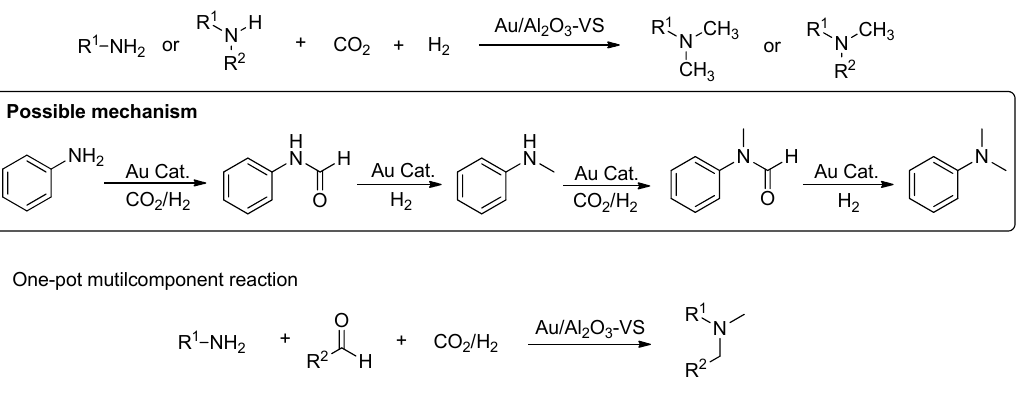
Scheme 35. Au-catalyzed methylation of amine with CO 2 and H 2.